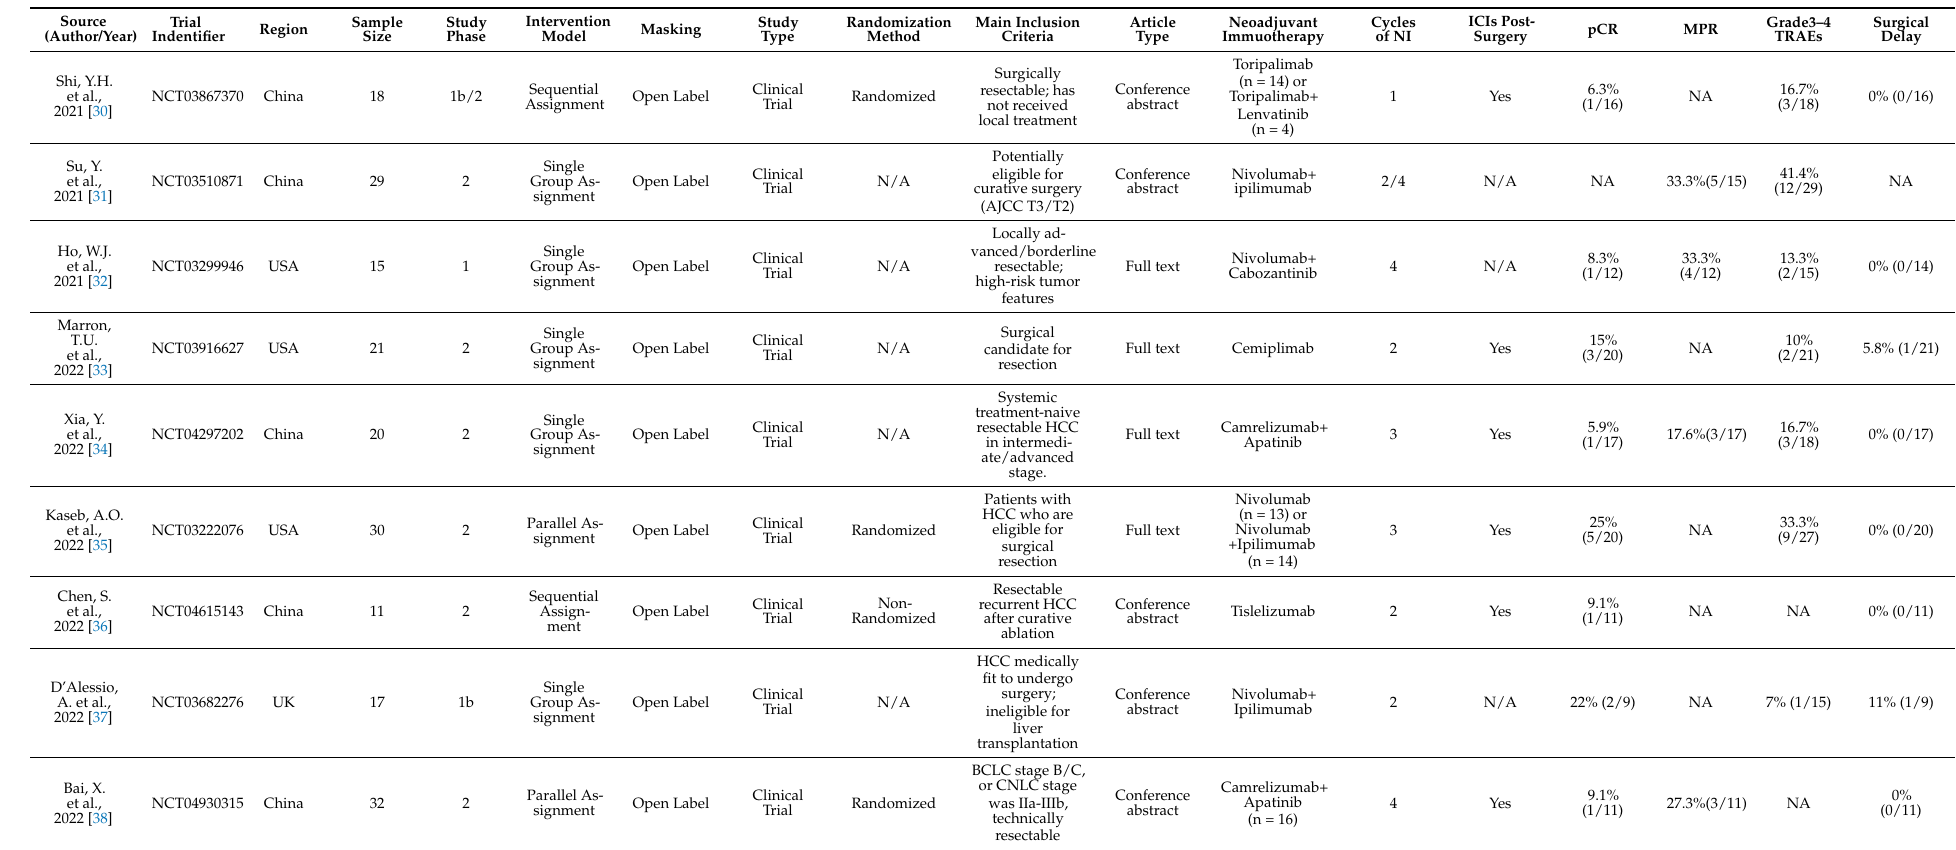
Table 1. Characteristics of neoadjuvant immunotherapy studies in patients with hepatocellular carcinoma. N/A, not applicable; HCC, hepatocellular carcinoma; NI, neoadjuvant immunotherapy; ICIs, immune checkpoint